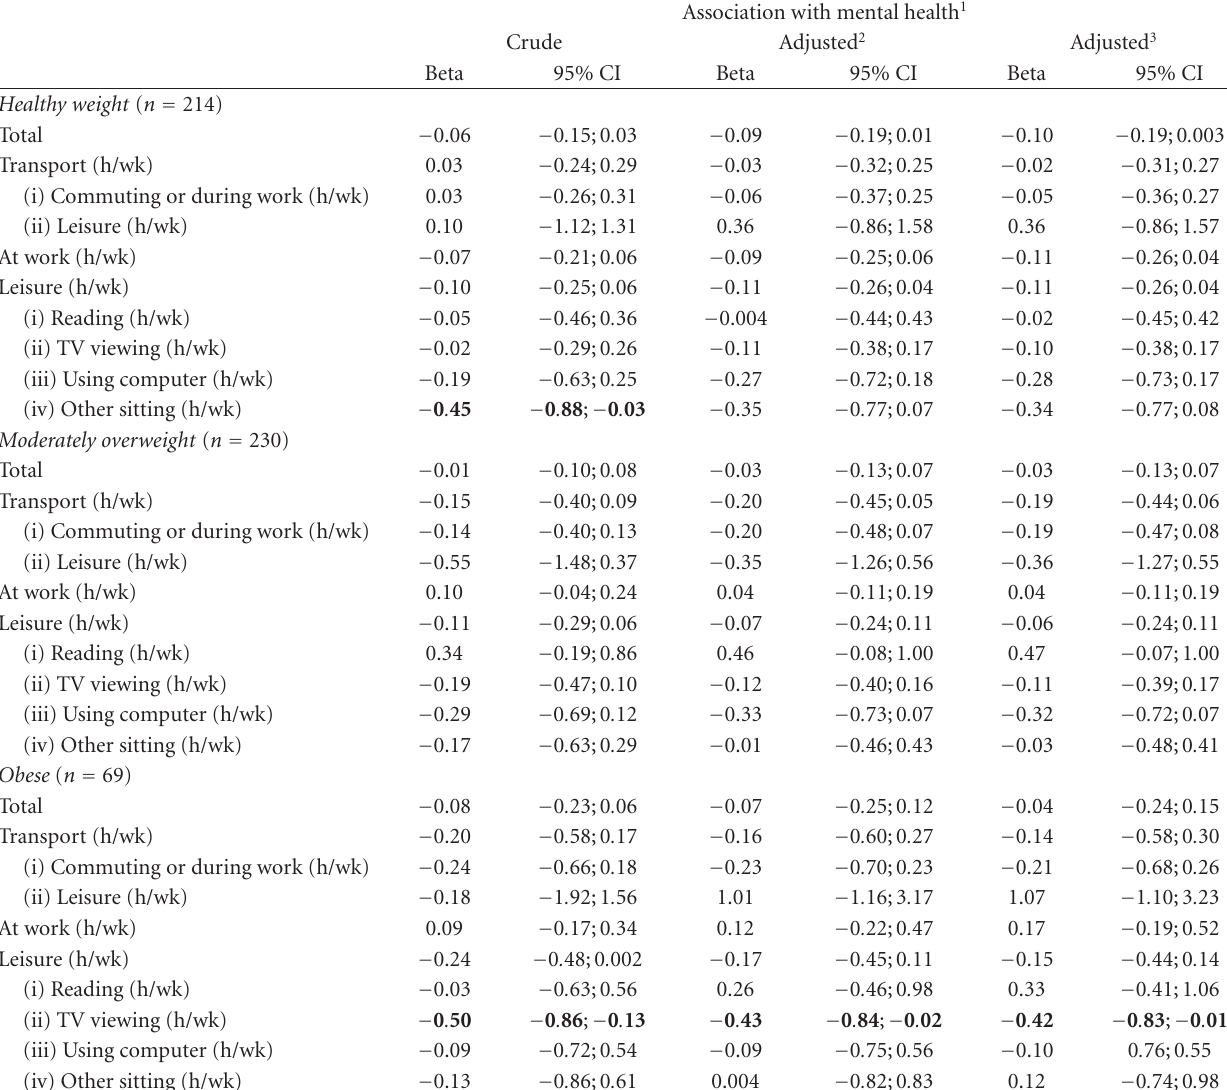
Association with mental health